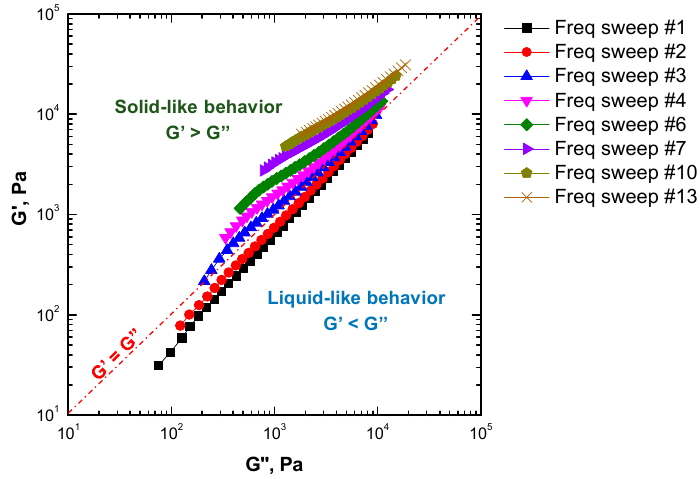
◦ C for ENR25 subjected to subsequent frequency Figure 2. Curves of G’ vs. G” at 180 °C for ENR25 subjected to subsequent frequency sweeps. Figure 2. Curves of G’ vs. G” at 180